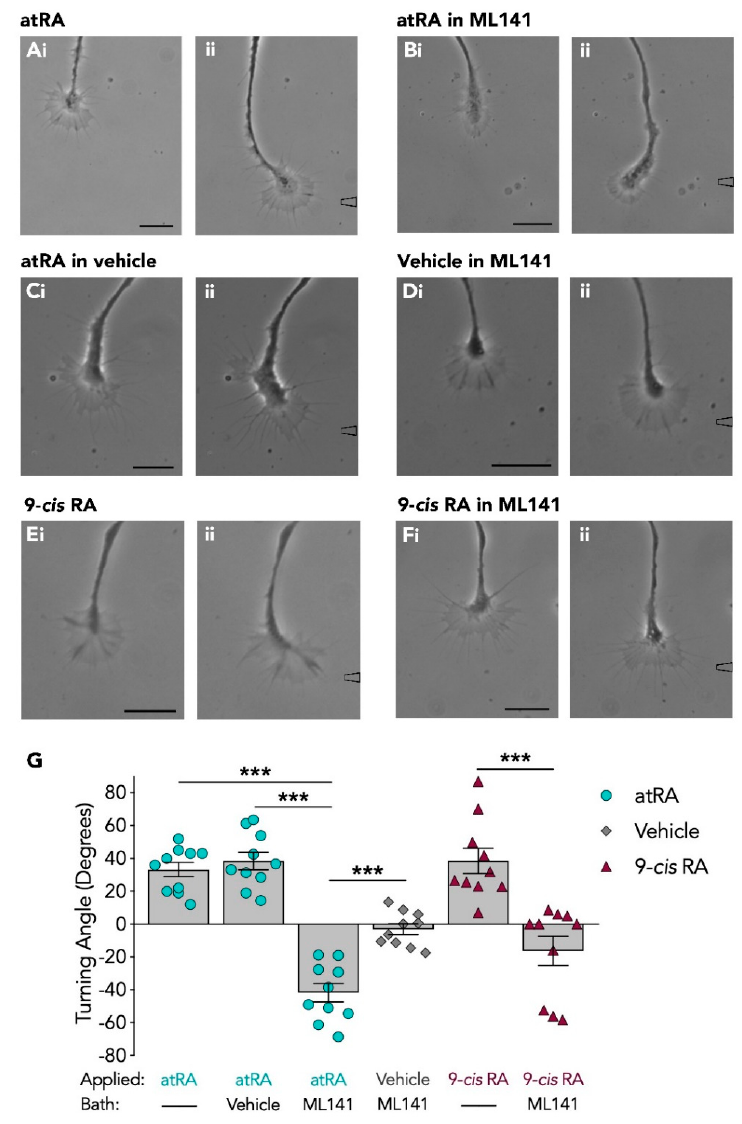
Figure 1. Inhibiting Cdc42 switches the atRA, but not 9- cis RA-induced growth cone response from attraction to repulsion. The first image of each data set ( A – Fi ) illustrates the growth cone prior to application of the retinoid / vehicle (t = 0), whereas the second image of each data set ( A – Fii ) represents the growth cone response. The approximate location of the pipette containing either retinoid or vehicle is shown to the right of an image ( A – Fii ) and times (t) of growth cone responses are given in minutes. Application of atRA induced attractive growth cone turning in normal conditions ( Ai – ii ; n = 10; t = 53), as well as in the presence of the vehicle in the bath ( Ci – ii ; n = 10; t = 24). This attractive growth cone turn was abolished and converted to a repulsive turn (away from pipette) in the presence of the Cdc42 inhibitor, ML141 ( Bi – ii ; n = 10; t = 50). Vehicle (applied via pipette) in the presence of ML141 did not induce significant turning responses ( Di – ii ; n = 10; t = 31). Application of 9- cis RA also induced attractive growth cone turning ( Ei – ii ; n = 10; t = 12) which was blocked in the presence of ML141 ( Fi – ii ; n = 10; t = 21). Scale bars: 15 μ M. ( G ) Graph depicting the mean turning angles of growth cones in response to retinoid (or vehicle) in the presence or absence of the Cdc42 inhibitor, ML141 (*** p < 0.001).